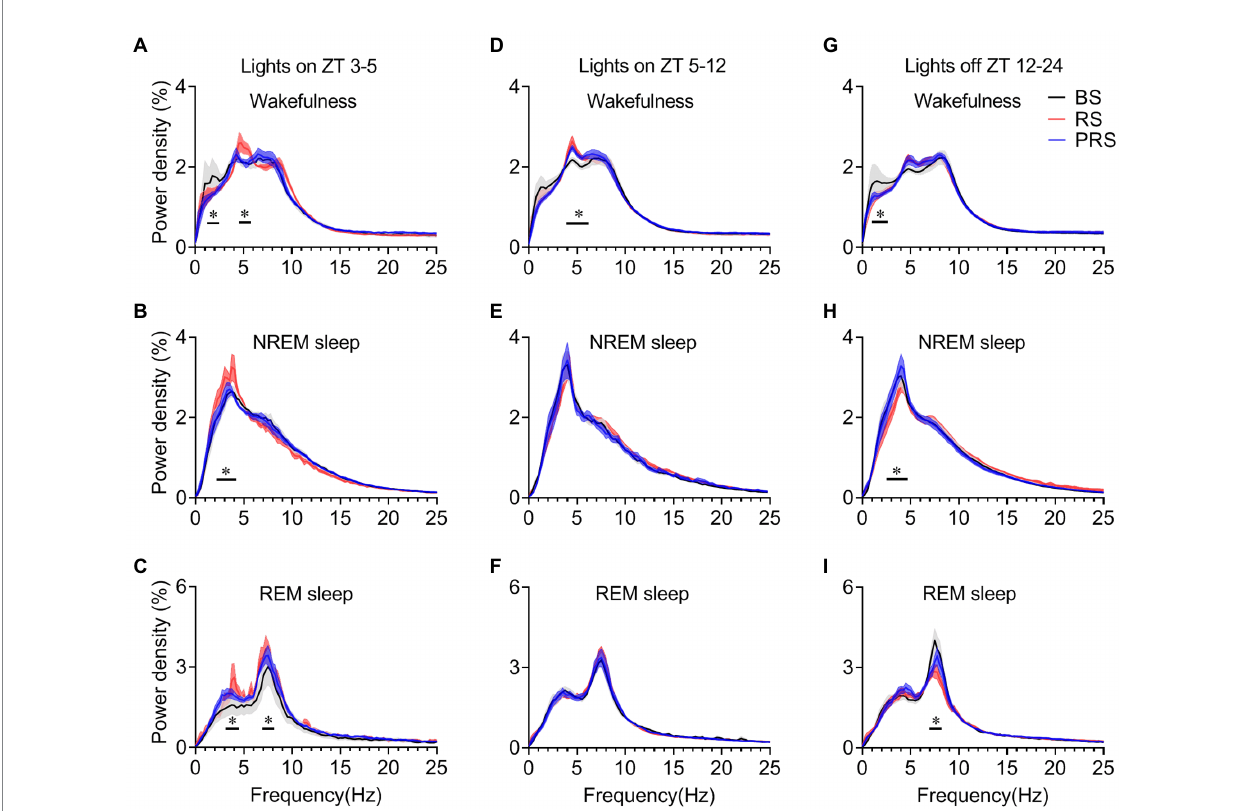
FIGURE 7 Changes in EEG power density during wakefulness, NREM sleep and REM sleep in the three time periods. EEG power density of wakefulness (A) , NREM sleep (B) and REM sleep (C) during ZT 3–5. EEG power density of wakefulness (D) , NREM sleep (E) and REM sleep (F) during ZT 5–12. EEG power density of wakefulness (G) , NREM sleep (H) , and REM sleep (I) during ZT 12–24. * p < 0.05, compared with baseline, n = 6. BS, baseline; RS, restraint stress; PRS, post-restraint stress; ZT, Zeitgeber